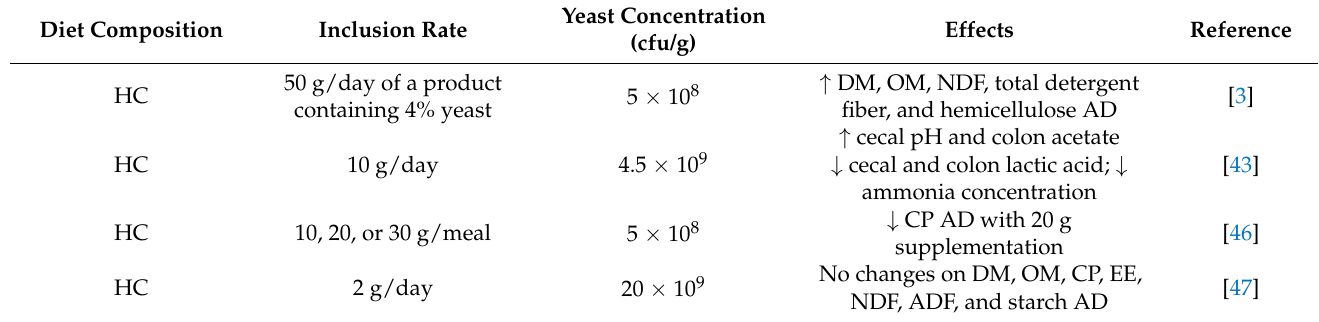
Table 1. Effects of S. cerevisiae on in vivo apparent digestibility